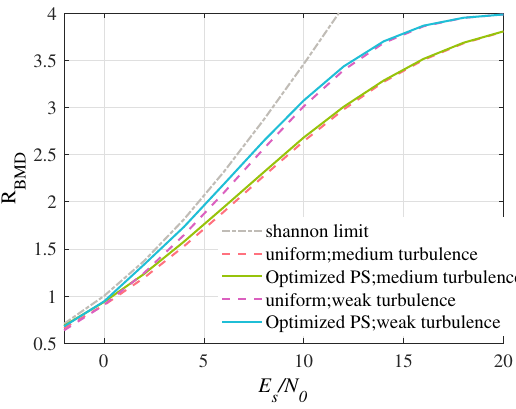
Figure 4. R BMD , optimized entropy at each E s / N 0 .